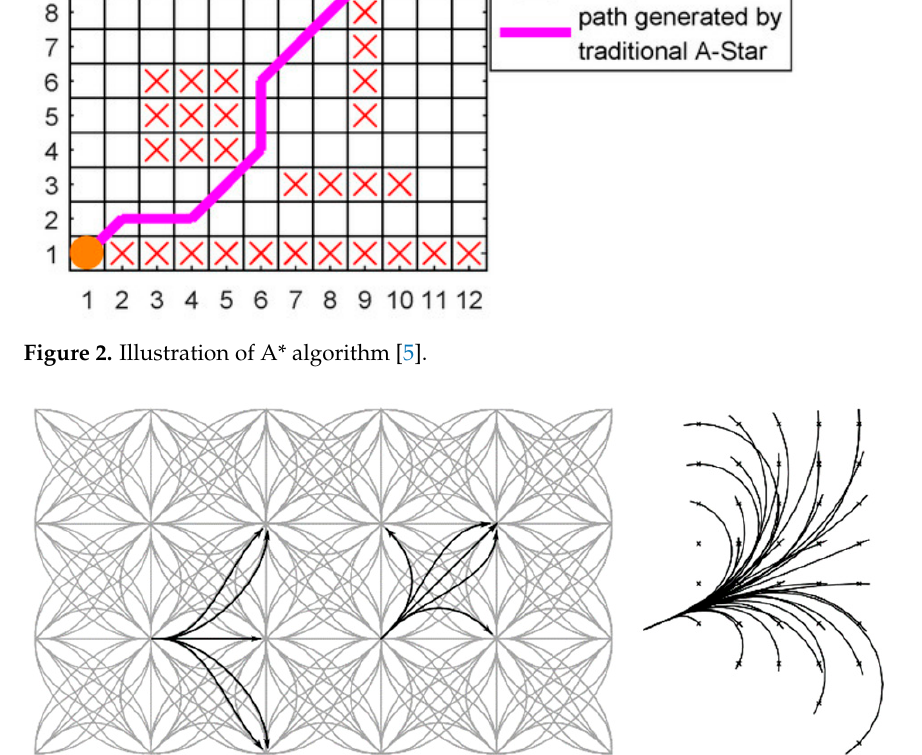
Figure 3. Illustration of State Lattices algorithm [10].